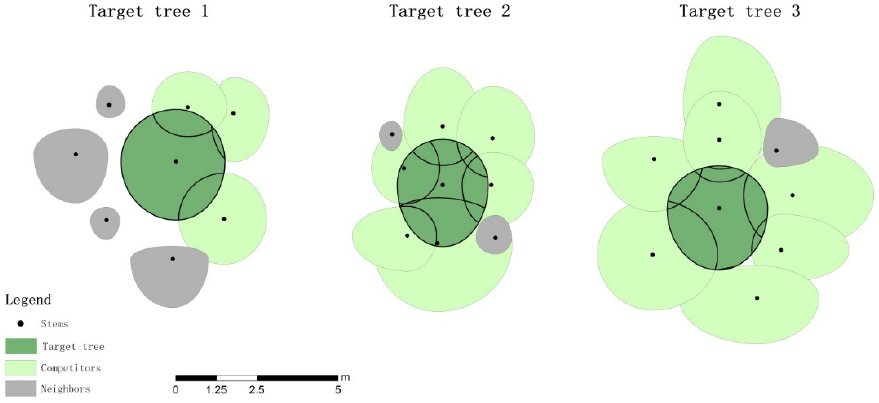
Figure 1. A schematic diagram of the identification of competitors relative to the target tree. The attributes of the plots, sample trees and corresponding competitors are listed in Table